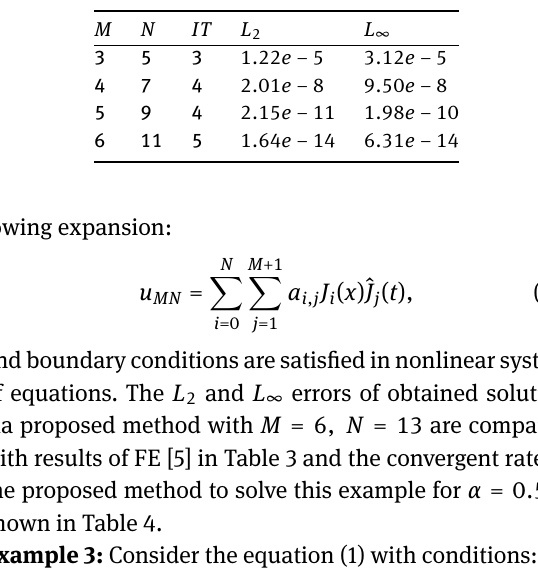
Table 2: The convergence rate of the proposed method to solve example 1 with α = 0.5